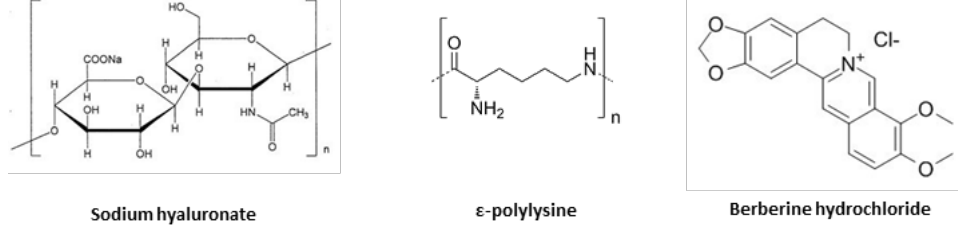
Figure 1. Chemical structures of sodium hyaluronan (HA), ε -polylysine (PL) and berberine hydrochloride.